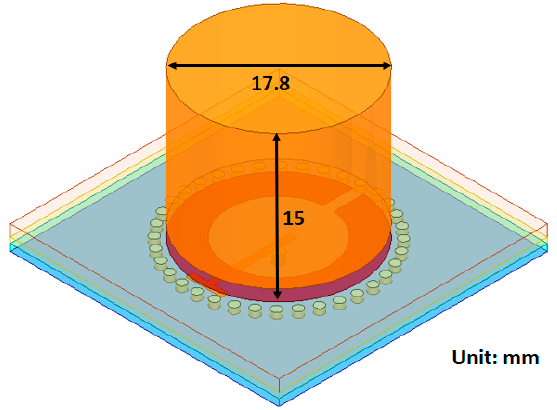
Figure 6. SIW sensor with a dielectric resonator block.